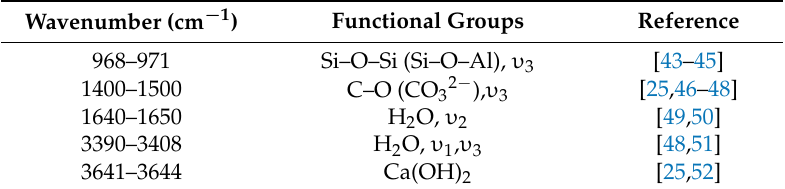
Figure 13. ATR-FTIR spectra for all the samples at the age of 28 days when ( a ) w/b = 0.5 and ( b ) w/b = 0.2. Table 4. Positions of infrared bands and functional groups in attenuated total reflection Fourier transform infrared spectroscopy (ATR-FTIR) spectra of OPC paste.